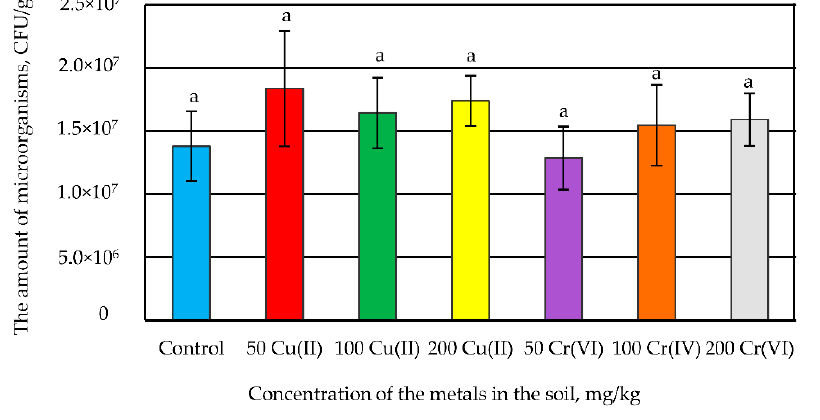
Figure 5. The influence of Cu(II) and Cr(VI) on soil microbiome ( х ± SD, n = 3); p < 0.05 with Bonferroni correction.